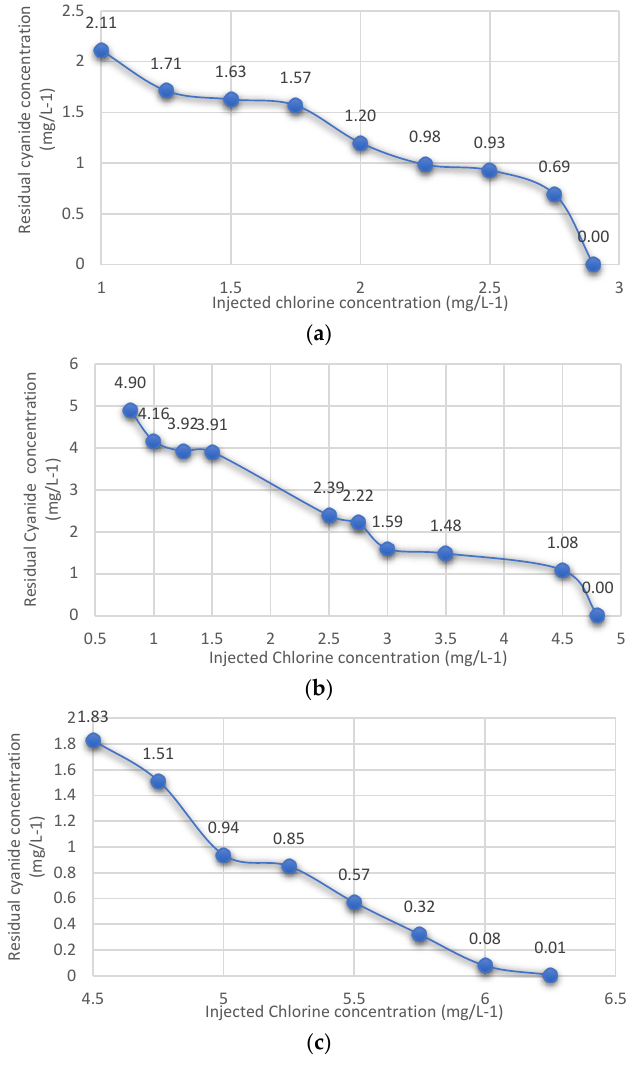
Figure 7. Diagram of changes of the residual cyanide in water at various concentrations of the injected chlorine as per—( a ) low contamination scenario ([CN − ] = 2.5 mg L − 1 ), ( b ) medium contamination scenario ([CN − ] = 5 mg L − 1 ), and ( c ) high contamination scenario ([CN − ] = 7.5 mg L − 1